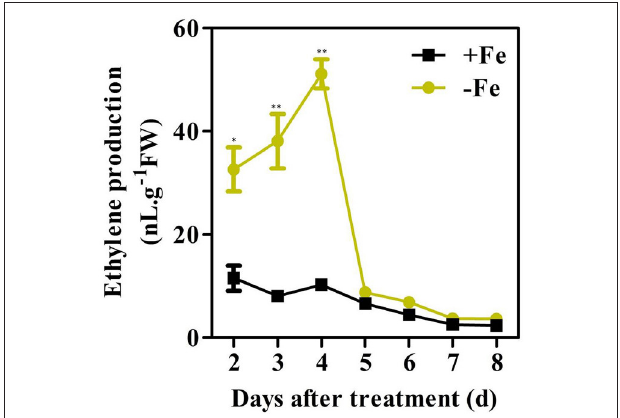
FIGURE 1 | Time-course analysis of ethylene production in WT plants under Fe-sufficient ( + Fe) and -deficient ( − Fe) conditions. Ten-day-old seedlings were transferred to Fe-sufficient (50 µ M EDTA-Fe) or Fe-deficient (0 µ M EDTA-Fe) nutrient solutions. For each time point shown, ethylene accumulated over a 24h period from 10 seedlings in the headspace of GC vials was measured. Data are shown as the mean ± SEM ( n = 3 ). Columns marked with “ * ” indicate a significant difference ( P < 0.05 ), and “ ** ” indicate a highly significantly difference ( P < 0.01 ).